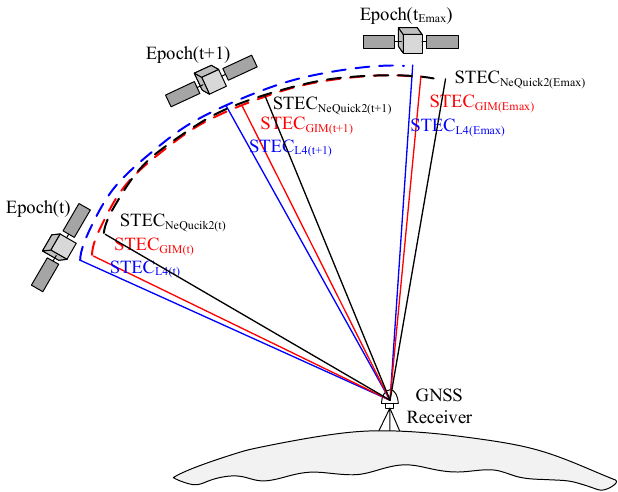
Figure 2. Schematic diagram of the evaluation principle of dSTEC.